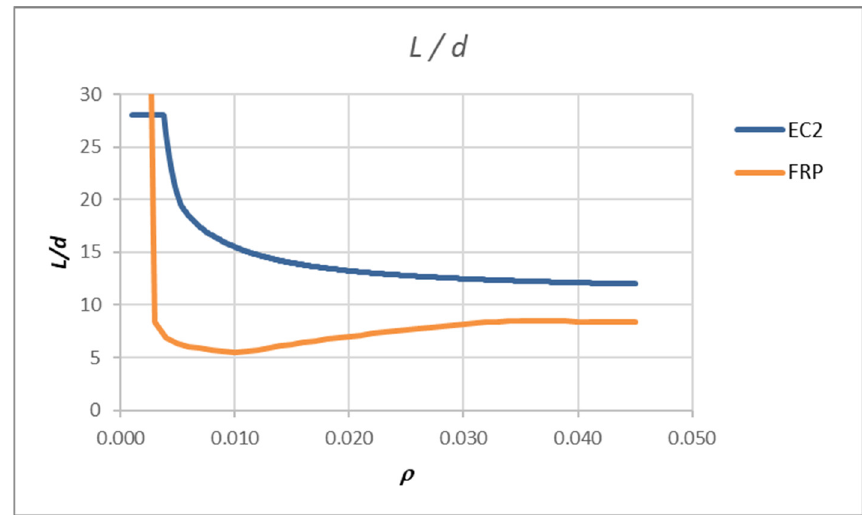
Figure 7. Results of analysis-limit span to depth ratio for FRPRC element compared with one for element with steel reinforcement according to [13] and [14].